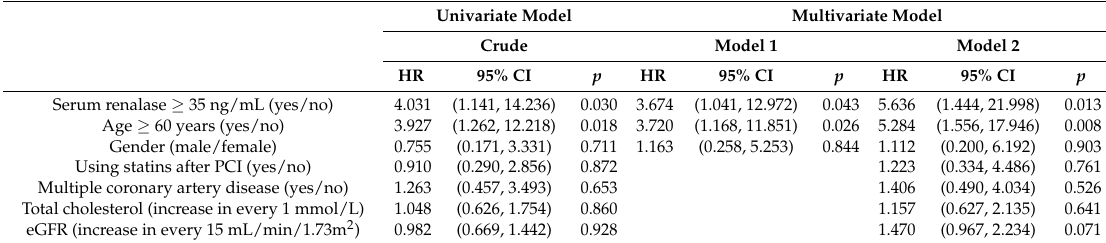
Figure 4. Kaplan–Meier curves showing risk of composite endpoint (incident myocardial infarction, stroke, or death) categorized according to median serum renalase (35 ng/mL) after percutaneous coronary intervention (PCI). Table 5. Effect of serum renalase levels after percutaneous coronary intervention (PCI) on composite endpoint (incident myocardial infarction, stroke, or all-cause mortality).